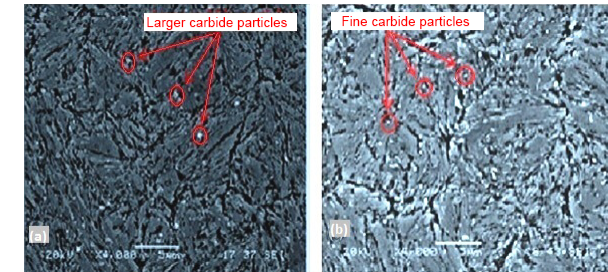
Figure 6. Scanning electron microscope (SEM) images of (a) CT and (b)